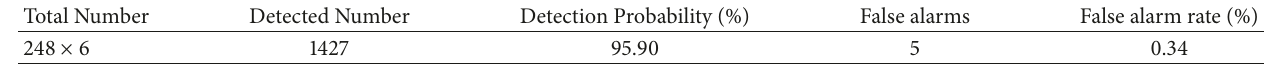
Table 4: Etection probability and false-alarm rate of the masking